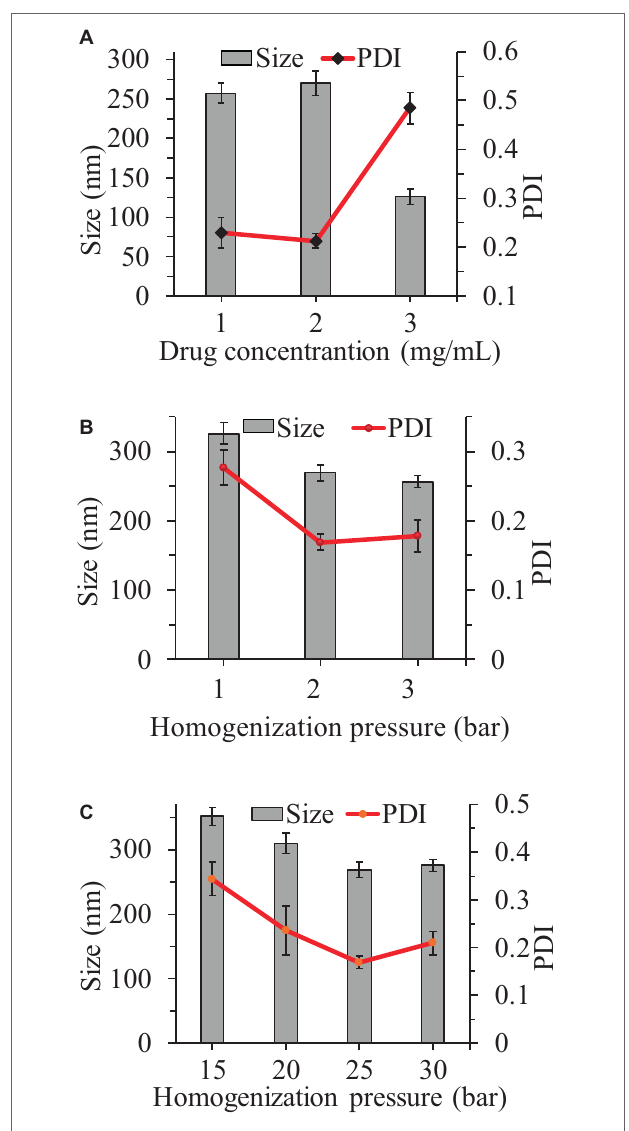
FIGURE 1 | Influence of the drug concentration (A) , homogenization pressure (B) , and homogenization cycles (C) on the particle size reduction of ITZ-Nanos. TABLE 1 | The mean particle sizes and zeta potentials of ITZ-Nanos. Parameters Before lyophilization After